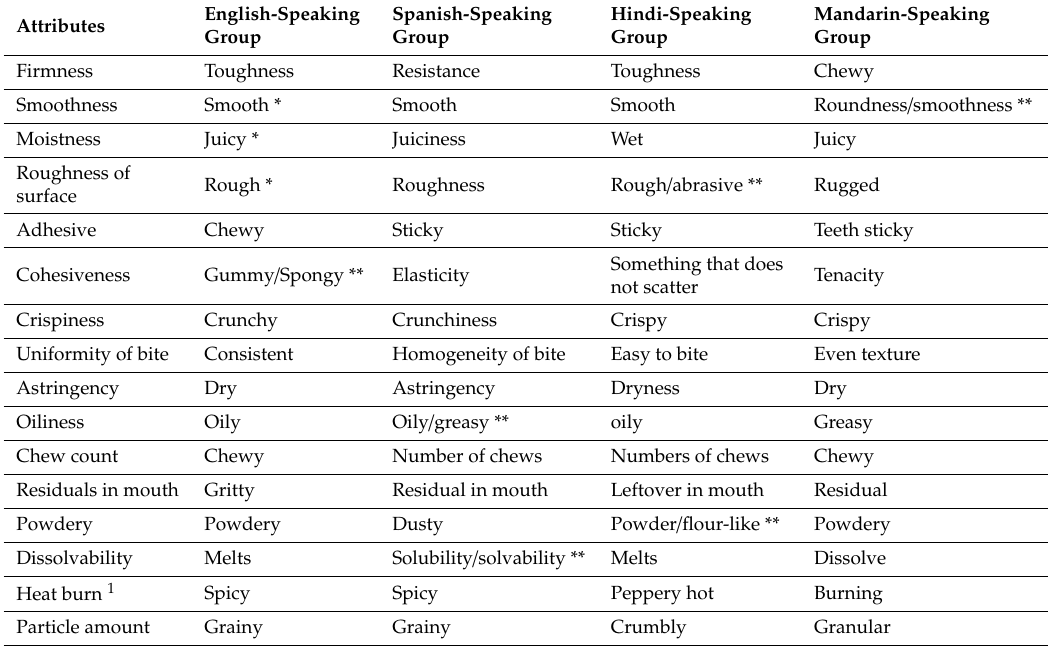
Table 8. Final consumer texture terms provided by each di ff erent language